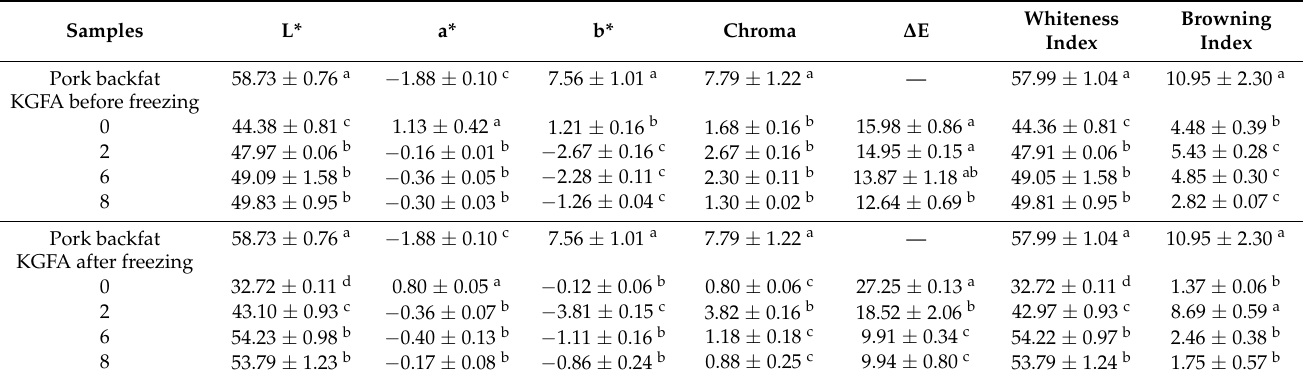
Table 2. Colour parameters of pork backfat (PBF) and konjac emulgel-based fat analogue (KGFA) with different ethanol content before and after freeze-thaw